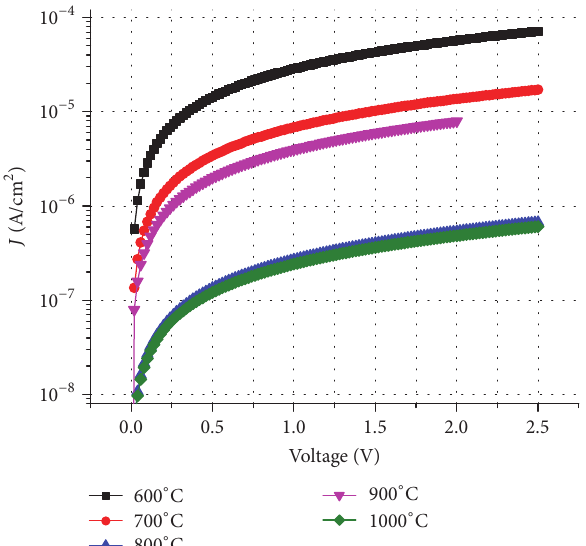
Figure 1: J - V curves for ultrathin ALD processed TiN gate in Si MOSCAP structure at different annealing temperatures.